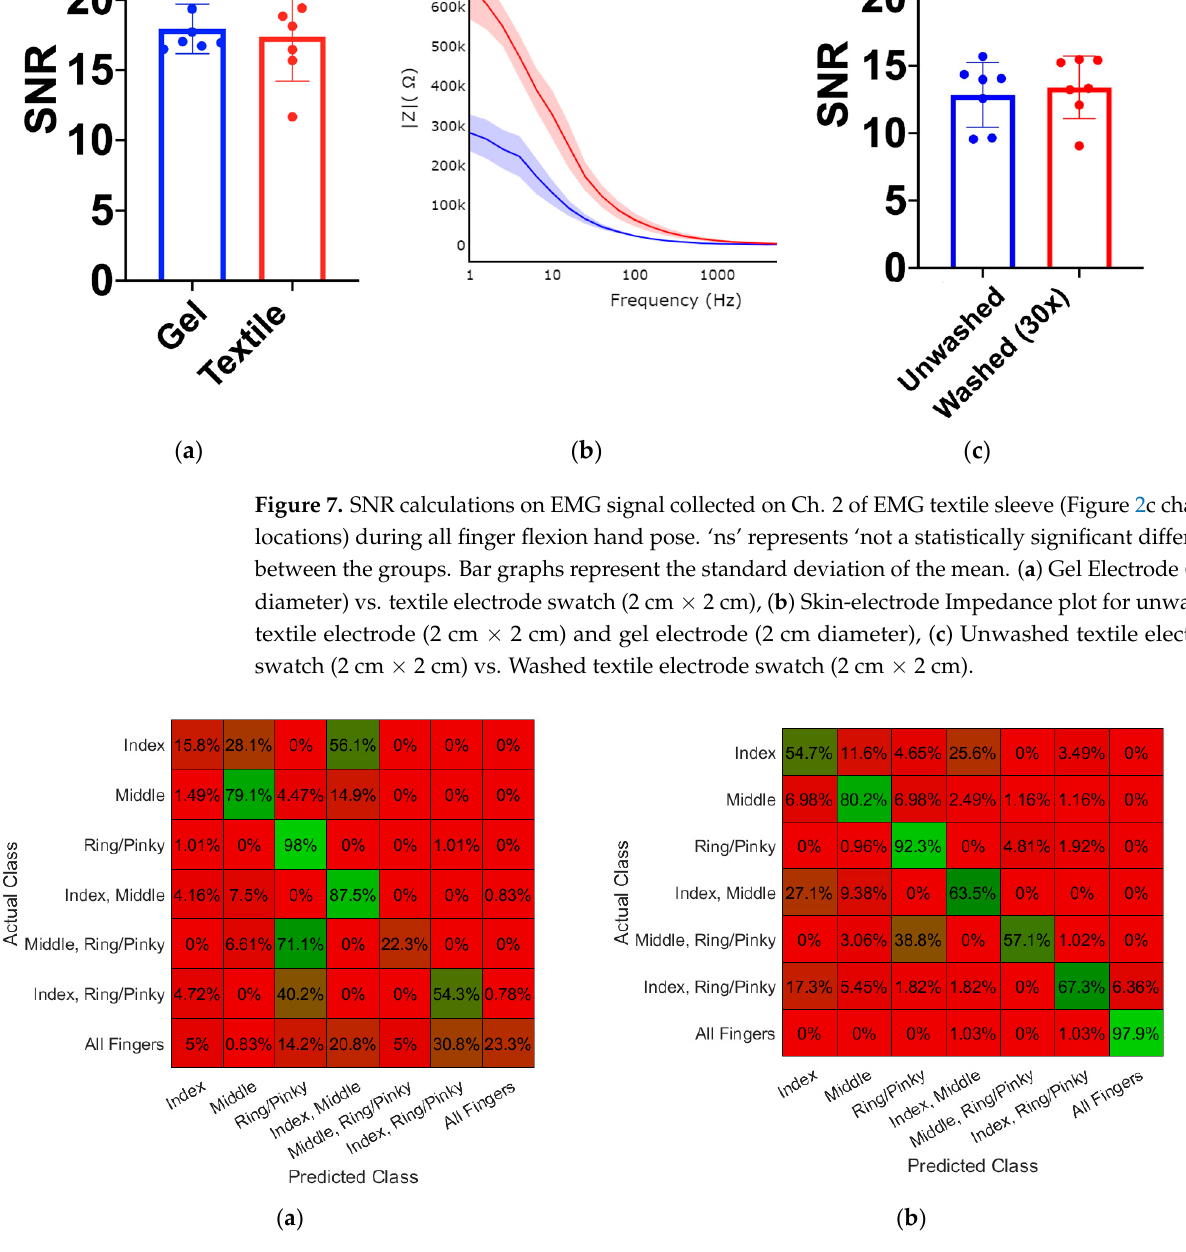
Figure 8. Offline classification performance and the associated confusion matrices of the trained models for finger gesture detection: ( a ) Offline classification with Gel Electrodes; ( b ) Offline classification with Unwashed EMG Textile Sleeve.